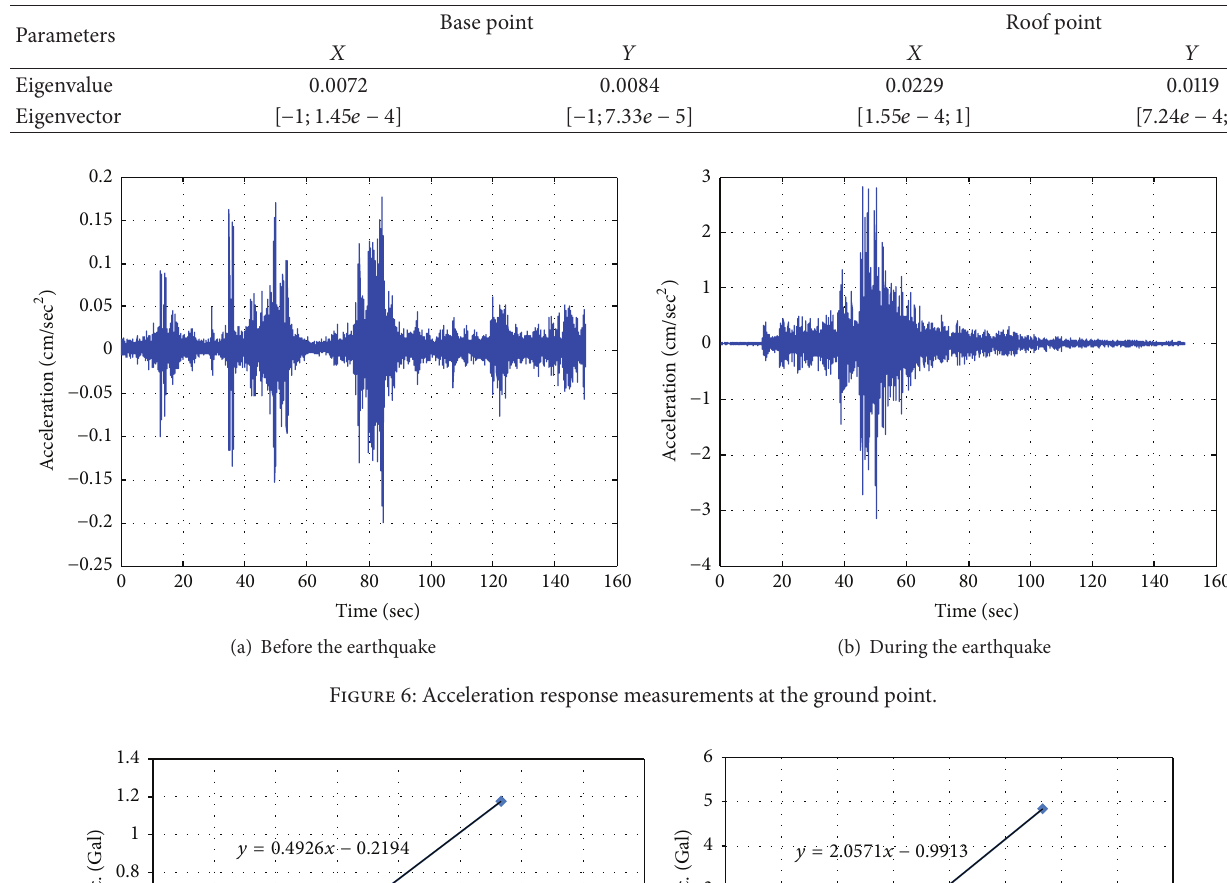
Table 3: Maximum eigenvalues and eigenvectors for covariance shaking point response matrix.